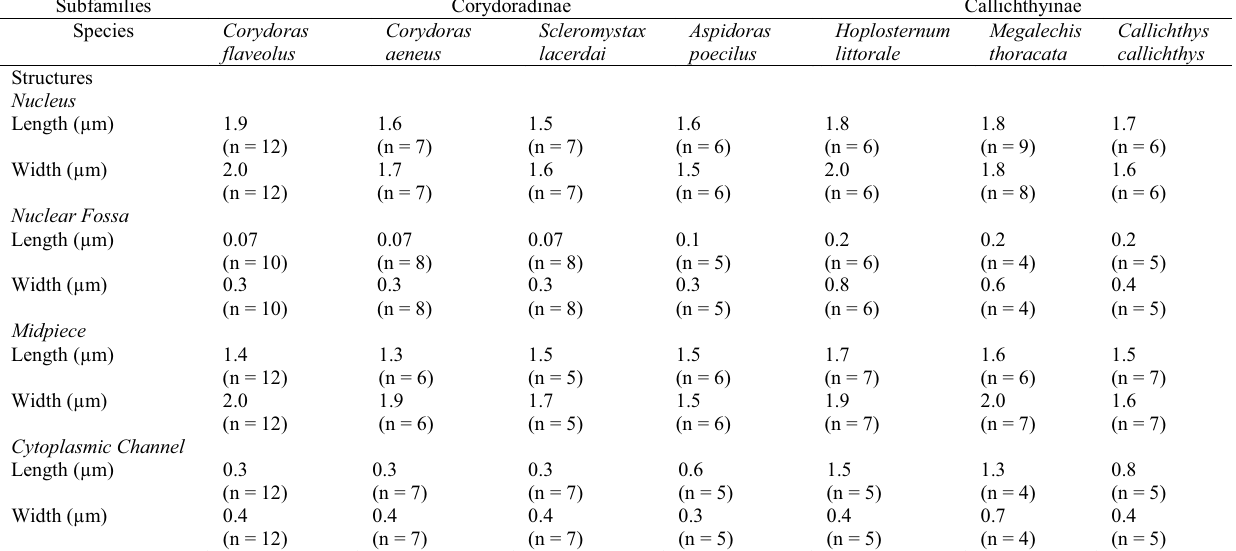
Table 1. Spermatozoa dimensions in callichthyids, in micrometers. The “n” shows the number of structures measured.